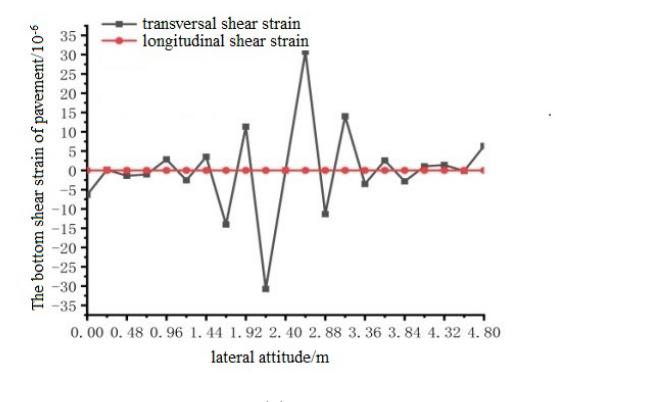
( b ) Figure 32. The transverse distribution of longitudinal and transverse shear stress on the bottom surface of the pavement with and without temperature field under the action of load level 3. ( a ) Longitudinal and transverse shear stress diagrams without temperature field; ( b ) Longitudinal and transverse shear stress diagrams with temperature field effect. From the results shown in Figures 30–32, it can be concluded that the transverse shear stress at the bottom of the pavement under the action of the temperature field and without